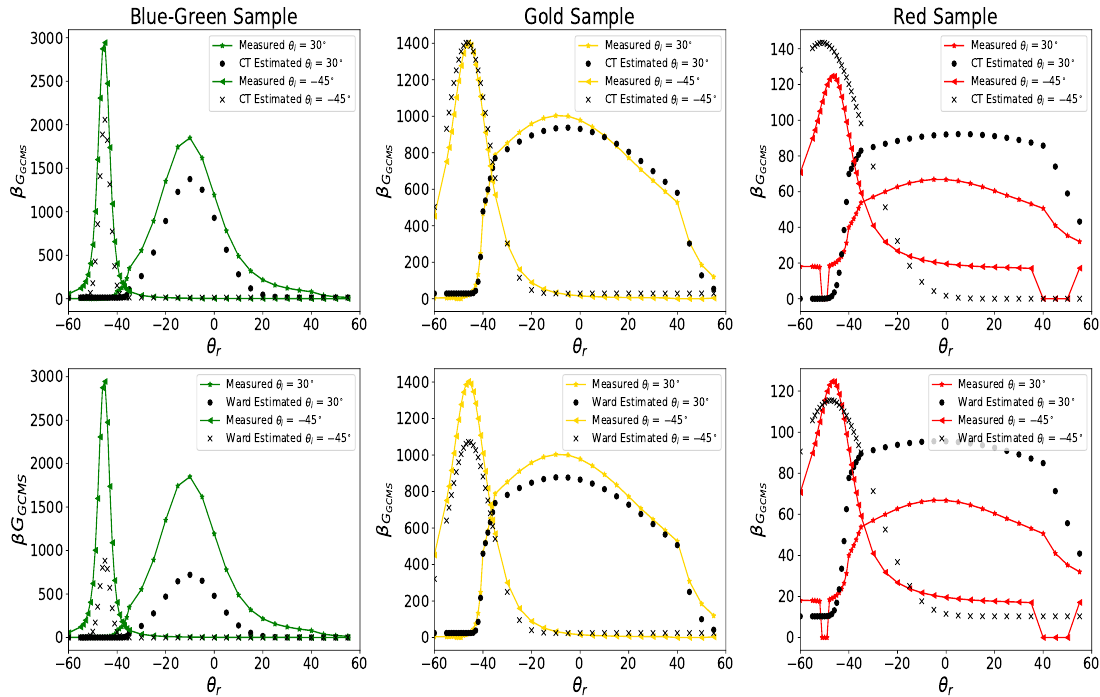
Figure 6. G-channel camera RGB data measured using GCMS and estimated using models fitted with the data set captured with θ L = − 25 ◦ using our measurement